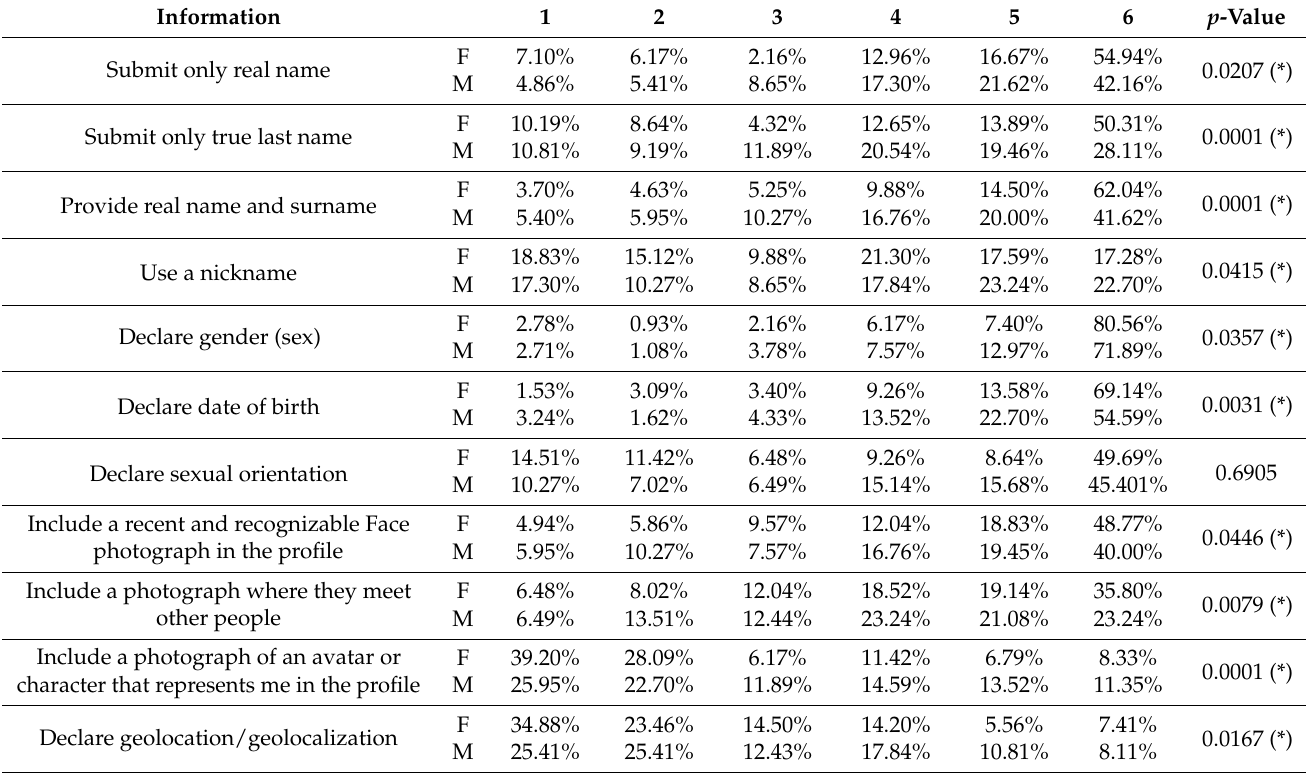
Table 6. Frequency with which they usually deliver information when requested on a platform.